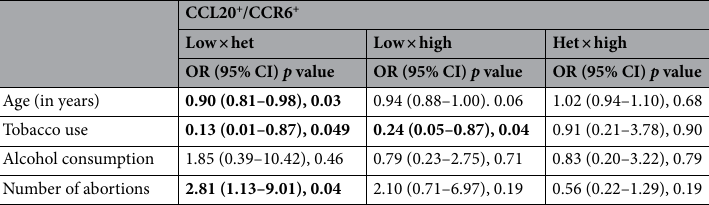
Table 5. Logistic regression analysis in CCL20 + /CCR6 + ‘immunoscore’ data. The bold values mean statistical differences between the